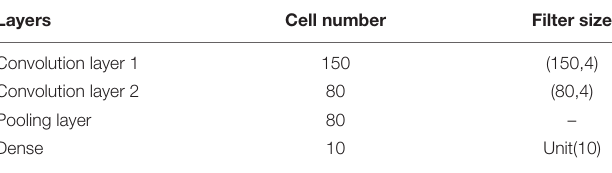
TABLE 1 | Structure of the CNN model for business sentiment